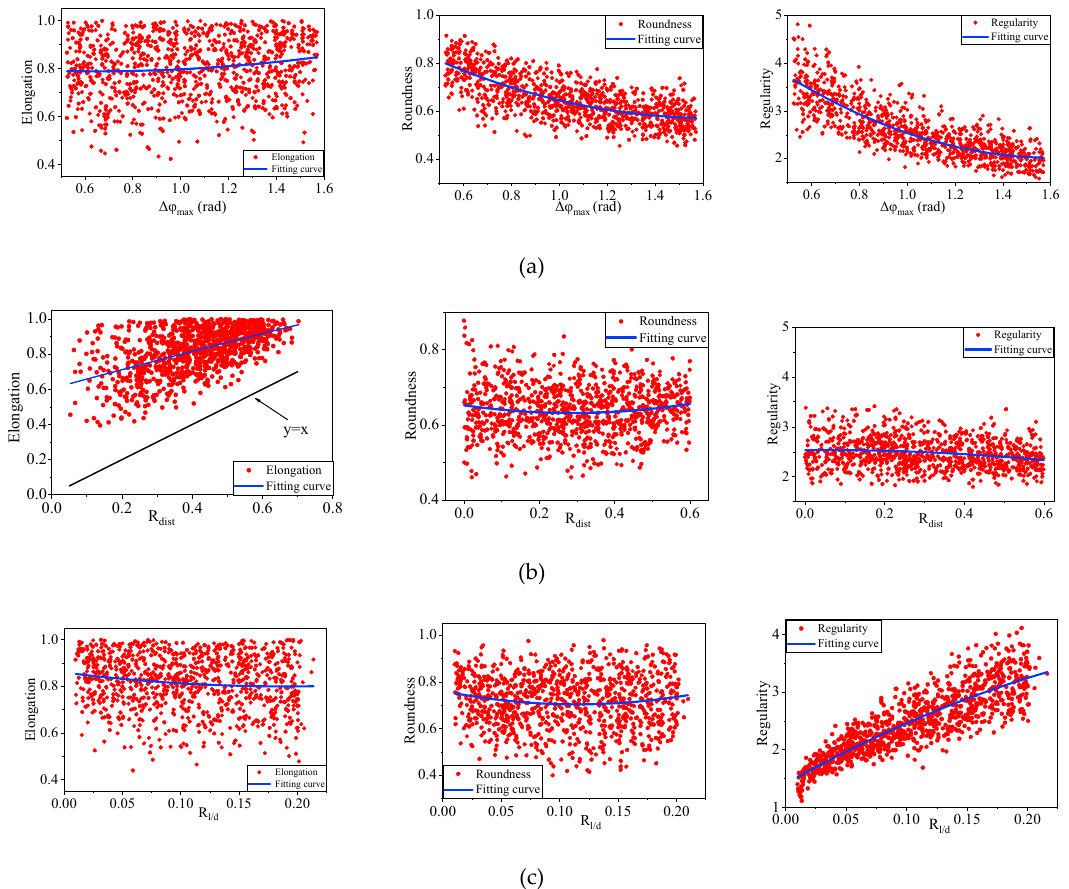
Figure 8. Influence of input parameters on shape descriptor: ( a ) Influence of ∆ ϕ max on particle shape; ( b ) Influence of R dist on particle shape; ( c ) Influence of R l / d on particle shape.